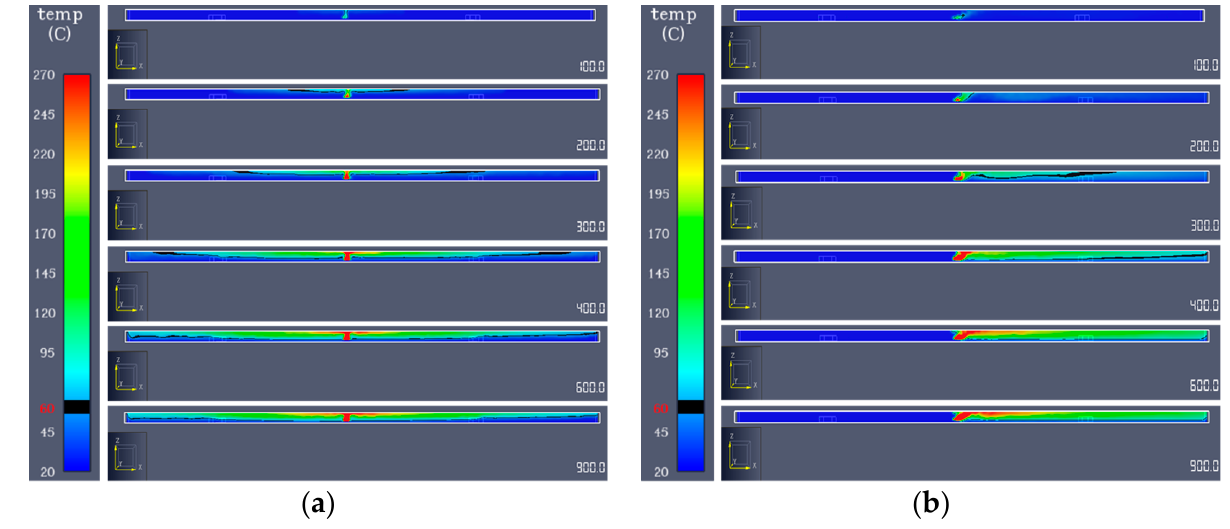
Figure 12. Changes in the longitudinal center section of temperatures: ( a ) 0.5 m/s; ( b ) 3.6 m/s. From the figures, T variations were centered around the fire source at 0.5 m/s longitu- dinal ventilation velocity, and upstream and downstream T differed slightly. Inside 100 m of the fire source, T was higher than the critical value, even though the T outside 100 m was lower. A velocity of 3.6 m/s reduced the temperature upstream of the fire to less than 60 ◦ C, while that downstream of the fire was higher than 60 ◦ C after 300 s. In addition,